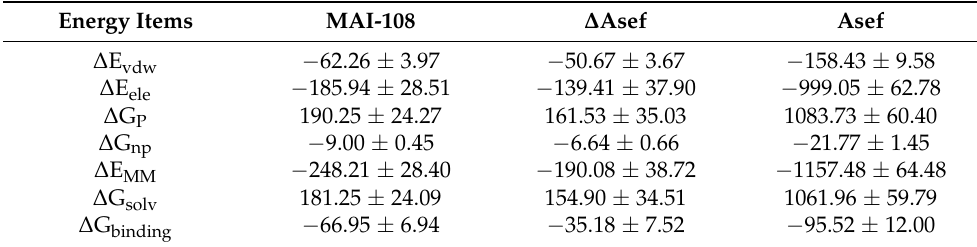
Table 2. Free energy values (kcal/mol) for the binding of MAI-108, ∆ Asef, and Asef to APC. Energy